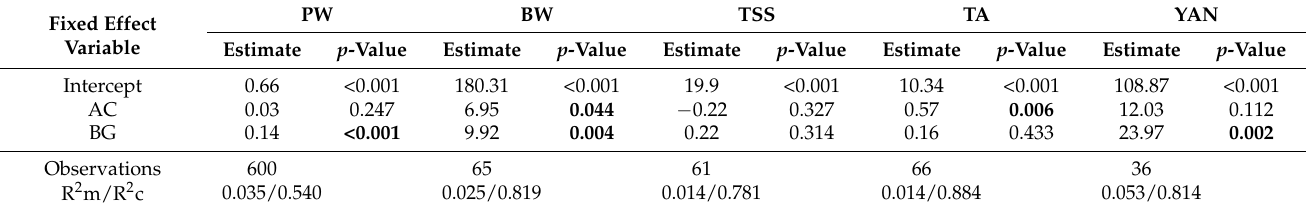
Table 3. Summary of the coefficients obtained by GLMM with the fixed factors inter-row ground cover treatment for the response variables of shoot pruning weight (PW), 100-berry weight (BW), total soluble solids (TSS), total titratable acidity (TA) and yeast assimilable nitrogen (YAN). Mixed models included the nested random factor (1|vineyard), and where data from more than one year existed, (1|vineyard/year). Significances were obtained using the likelihood ratio test. Marginal R 2 gives explained variation without, and conditional R 2 with the random factor. Gaussian distributions were utilized for all data sets. The p -values of significant predictors ( p < 0.05) are printed in bold. Treatments: AC (alternating vegetation cover), BG (bare ground), with CC (complete vegetation cover) as the baseline intercept.